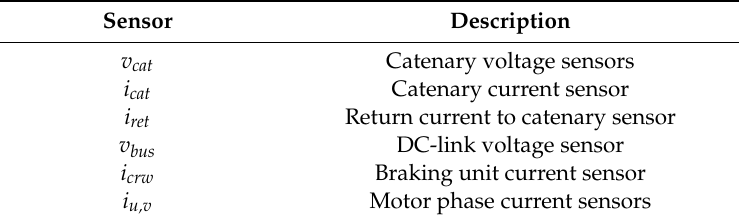
Figure 2. Railway traction unit. Figure 2 . Railway traction unit. Table 1. Current and voltage sensors in the Traction Control Unit